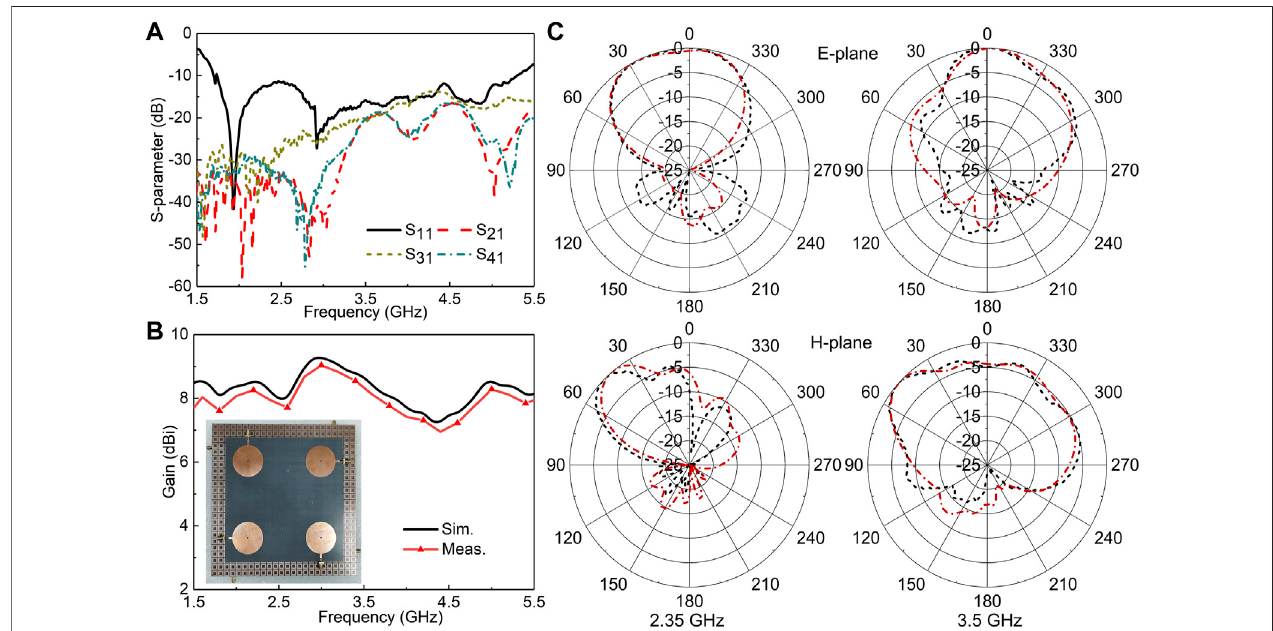
FIGURE 5 | Measured S-parameter (A) , gain (B) and radiation pattern (C) .